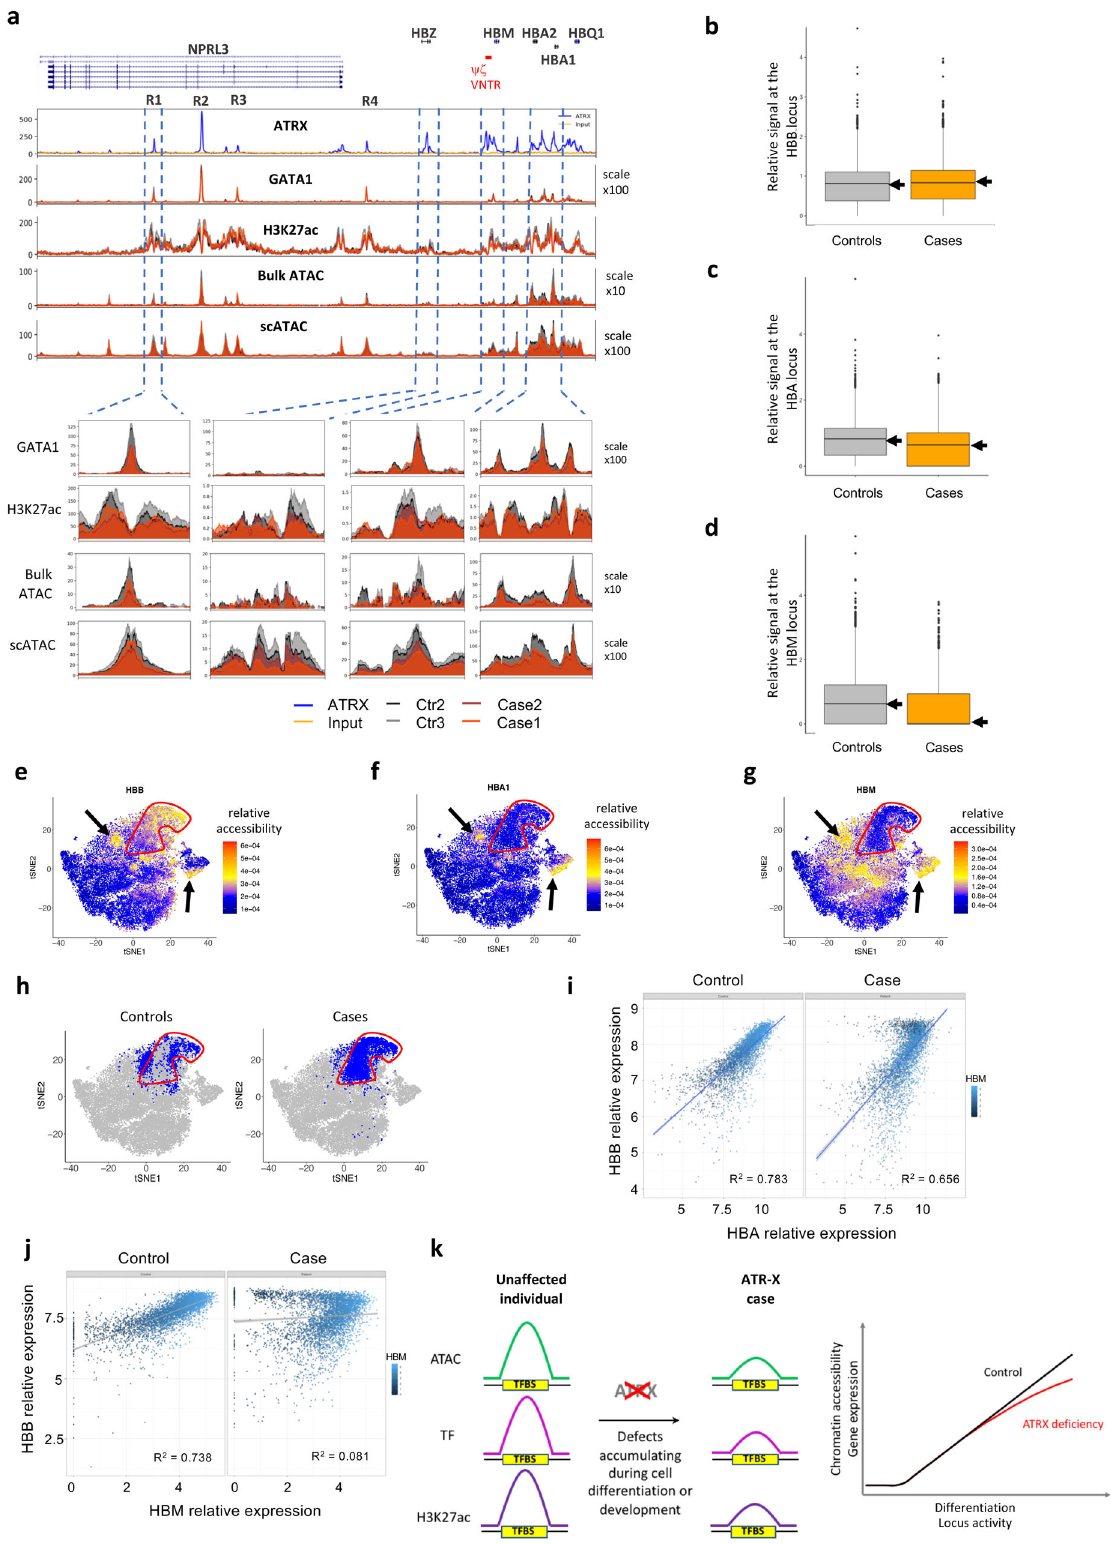
above 8), we detected a subpopulation of ATR-X cells with reduced HBA expression in case 1 (Fig. 5i). The reduced expression of HBA was supported by RNA-FISH data performed on erythroblasts from case 1 at day 10 and day 13 with the lower expression of HBA being most apparent at the later stages of differentiation (Supplementary Fig. 16e). Interestingly,